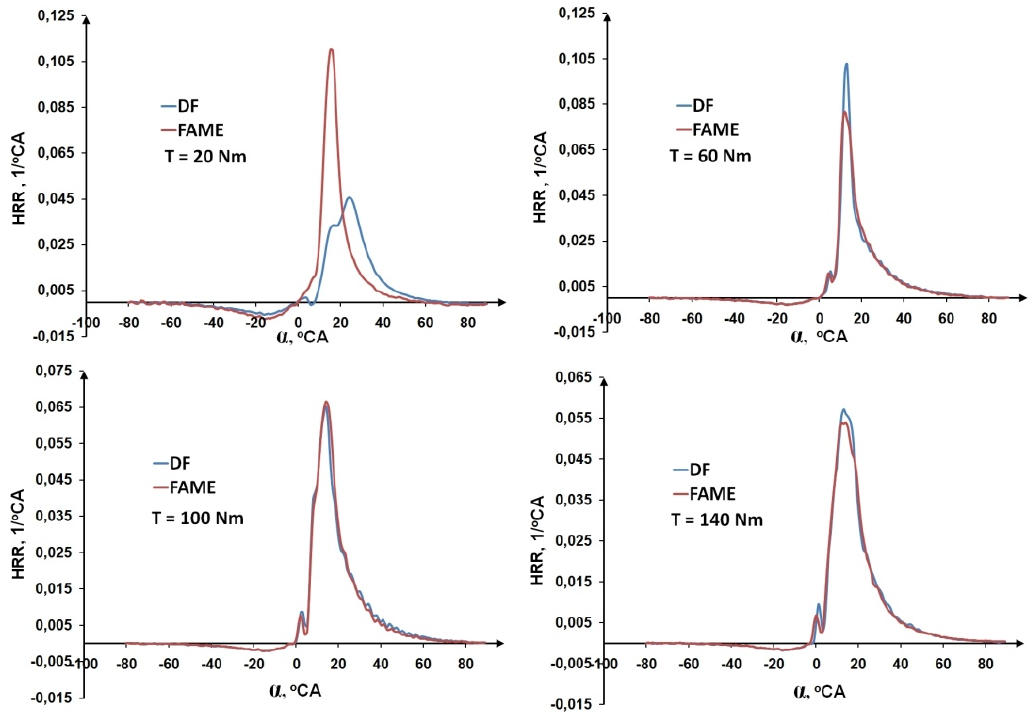
Figure 7: Characteristics of the relative heat release rate (HRR) during the combustion process in the cylinder of the Fiat 1.3 MultiJet engine supplied with the following fuels: FAME, DF, operating according to the load characteristics for n = 1750 rpm, with loads T = 20, 60, 100